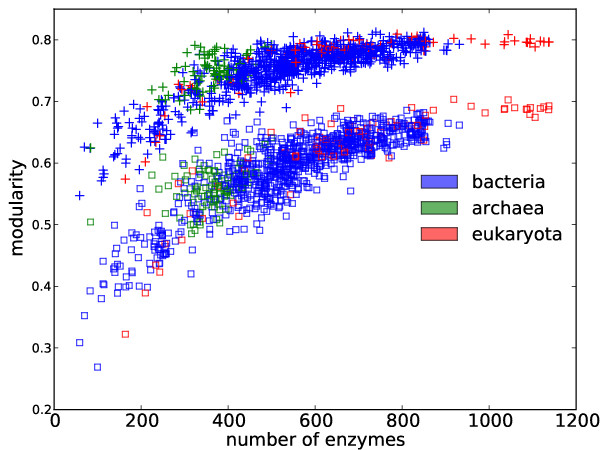
Modularity vs. the number of enzymes. The numbers of enzymes are significantly correlated with modularity scores (“+” markers). Such observation remains after modularity scores are normalized (square markers).